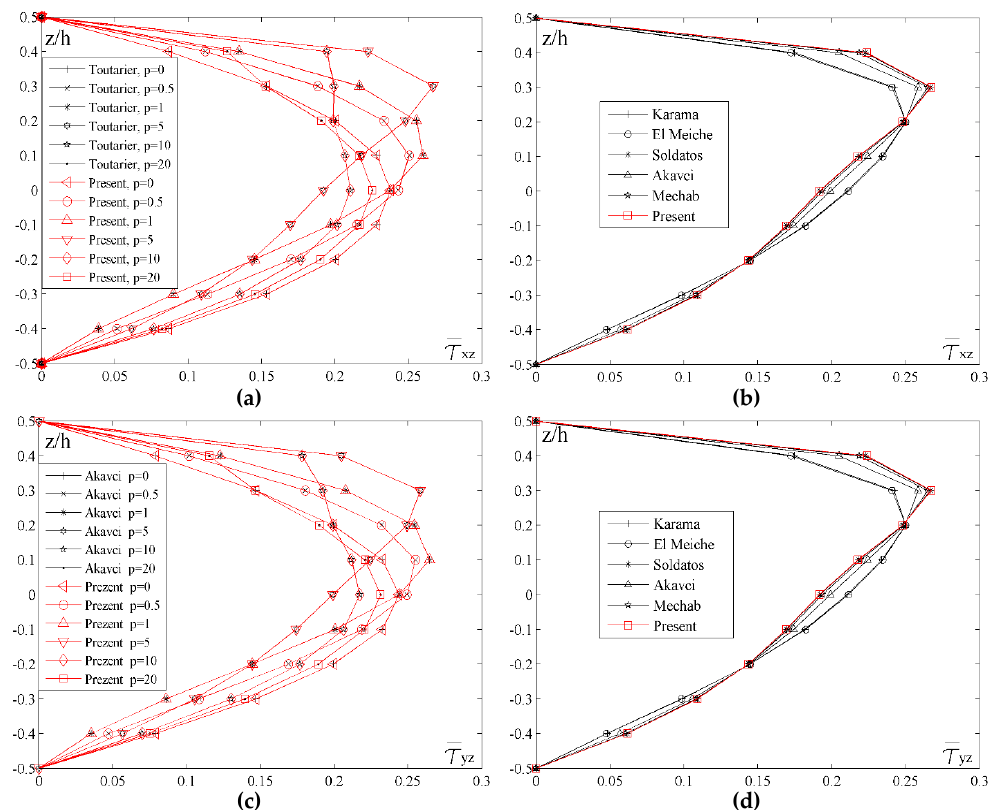
Figure 8. Distribution of the normalized values of the transverse shear stresses τ xz and τ yz across the thickness of the plate for different values of the index p and different shape functions: ( a ) a / h = 10, a / b = 1; ( b ) a / h = 10, a / b = 1, p = 5; ( c ) a / h = 10, a / b = 1; ( d ) a / h = 10, a / b = 1, p = 5. In order to understand the effects of increasing the index p as well as the effect of the thickness and geometry, Figure 9 shows the diagram of the normalized values of the displacement w for different a/h and a/b ratios and values of the index p. By analyzing Figure 9a and Figure 9b, it could be noticed that the displacement values w for the metal plate ( p = 20) are the highest, for the ceramic plate they are the lowest, and for the FGM plate they are somewhere in between. Moreover, by varying the volume fraction of metal or ceramics, a desired bending rigidity of the plate could be achieved. In Figure 9a, it could be seen that the curves gradually become closer when a/b > 4. In contrast to that, Figure 9b shows that with an increase of the ratio a/h the curves do not become closer, namely, the difference of the displacement ratio remains constant regardless of the index p change. This conclusion comes from the fact that in thin plates it is less possible to vary the volume fraction of the FGM constituents in the thickness direction of the plate and, thus, the index p has no effects.